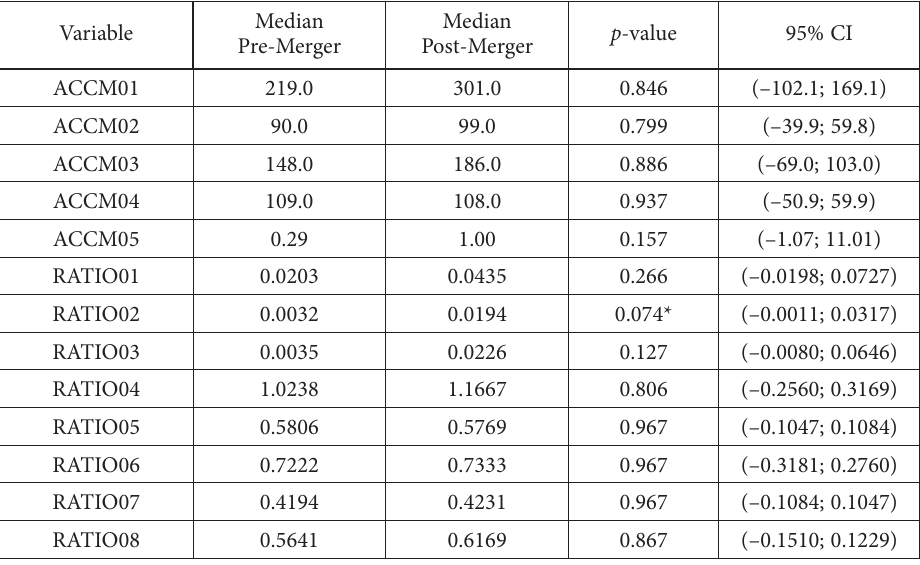
Table 5b. Comparison results (with median) of mergers with pre- and post-analysis of the sample firms